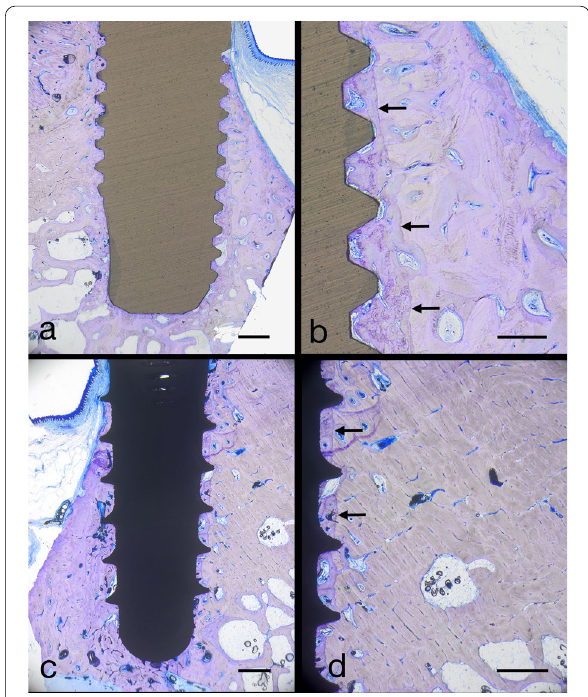
Fig. 5 LM micrographs showing complete osseointegration after 8 weeks around YTZP implants ( a , b ) and Ti-SLA implants ( c , d ). Note the osteotomy walls (black arrows in b , and d ). Scale bars: 1